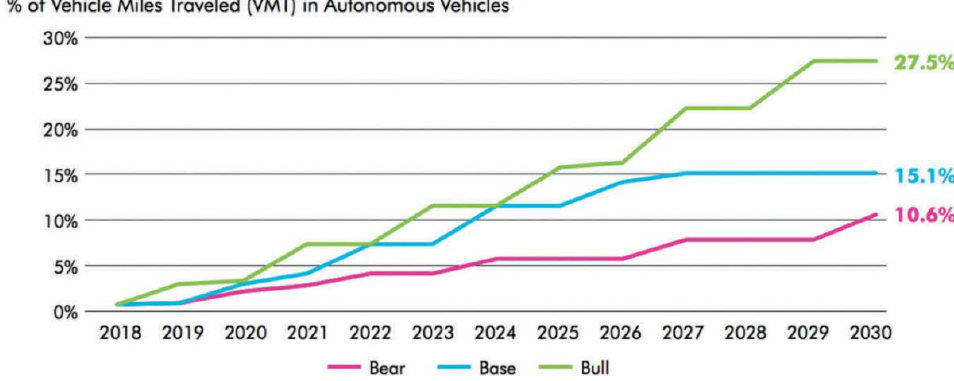
Figure 1. Comparison of prediction of the popularization trend of SAV by different scholars or institutions (adapted from [11]).